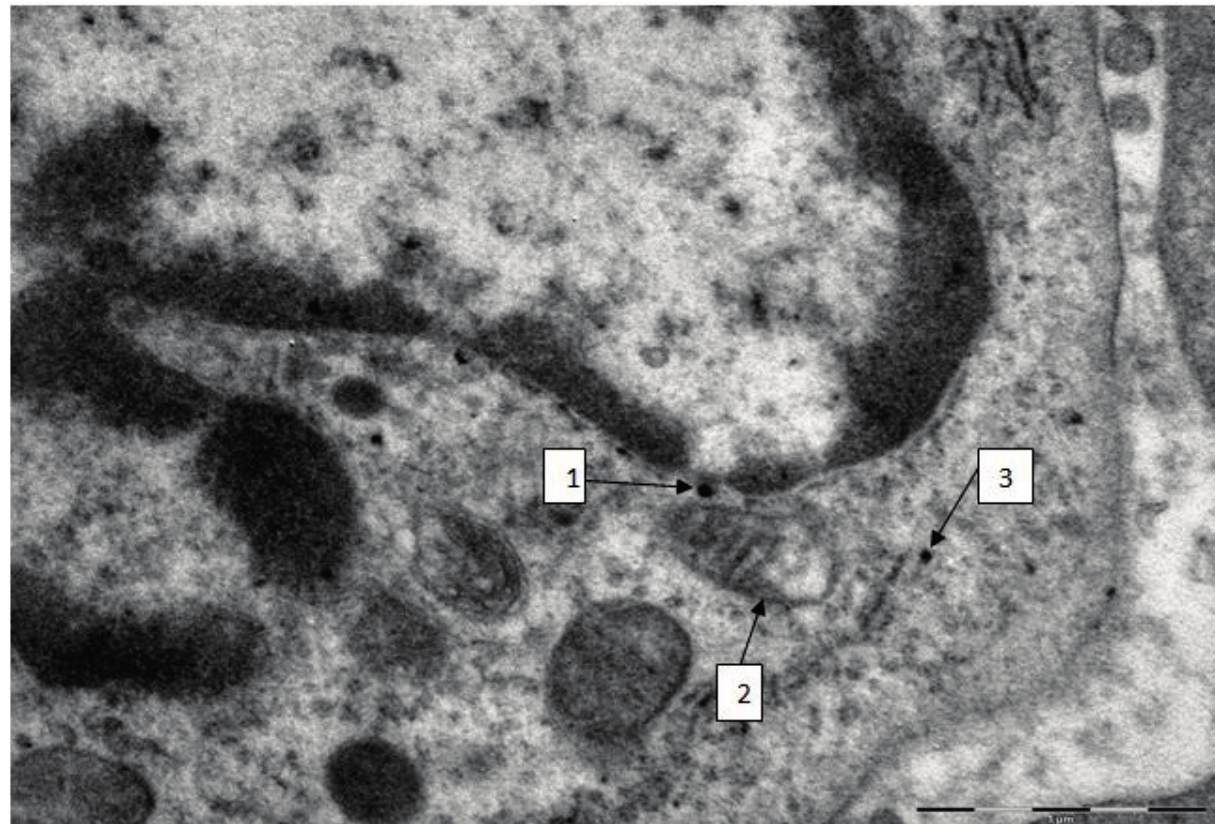
Figure 3. Alveolar macrophage from the BALF of a rat administered copper oxide NPs (TEM, magnification ×22,000). There is a solitary NP close to the nuclear membrane (arrow 1). Note that in the particle localisation area the membrane is blurred and lacks its double contour image. The mitochondrion near this particle (arrow 2) partly lacks cristae and the electron density of its matrix is reduced; the remaining cristae show signs of destruction, and the mitochondrial membrane is blurred, partly broken, and lacking double contour in some places. There is nearby a solitary nanoparticle within the “shadow” of a destroyed mitochondrion (arrow